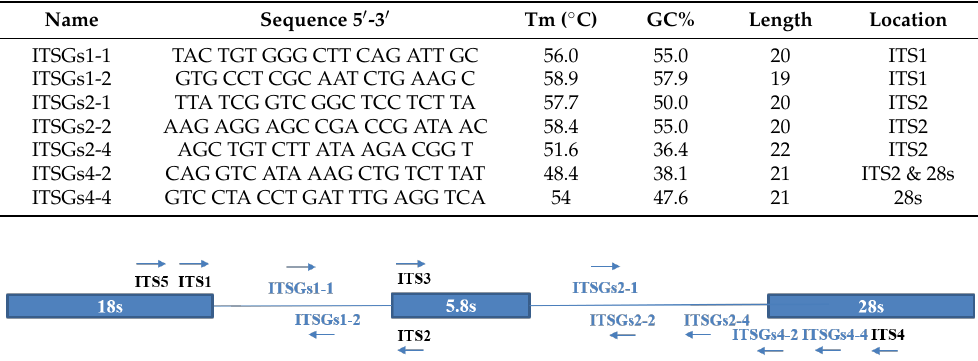
Figure 1. The locations of primers in the internal transcribed spacer (ITS) region; the arrowheads represent the 3 ’ end of each primer (primers designed in this study are in blue).